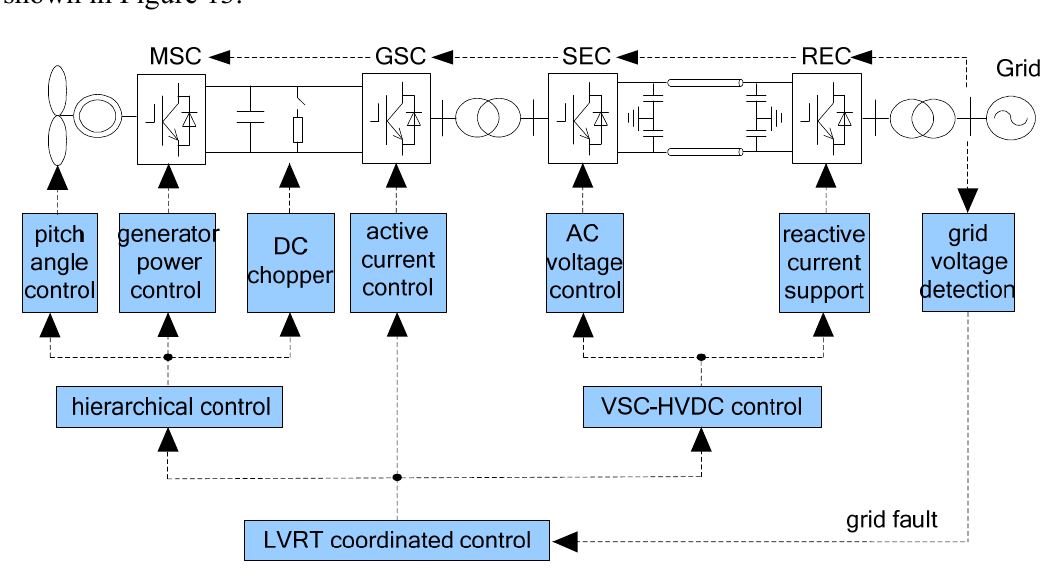
Figure 13. The LVRT coordinated control diagram of VSC-HVDC-based wind power